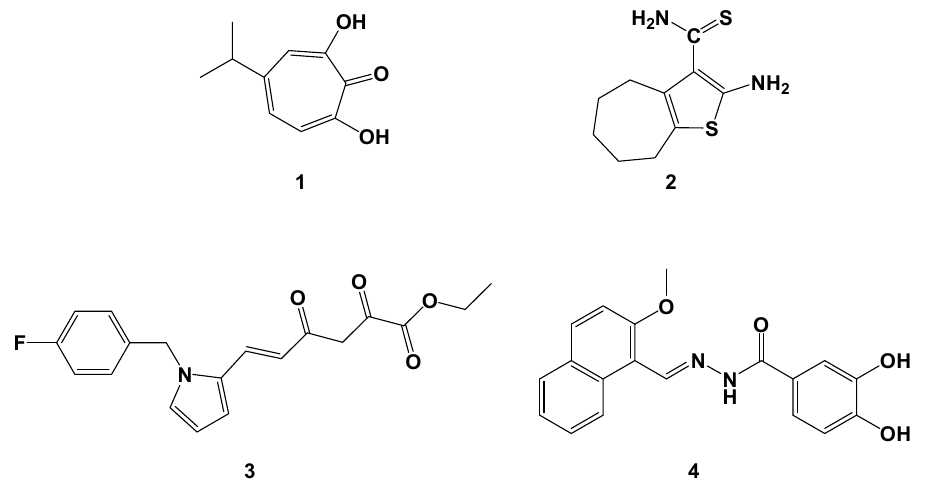
Figure 1. Examples of different RNase H inhibitors: β -thujaplicinol ( 1 ), vinylogous urea ( 2 ), β -ketoester ( 3 ), and hydrazone ( 4 ).